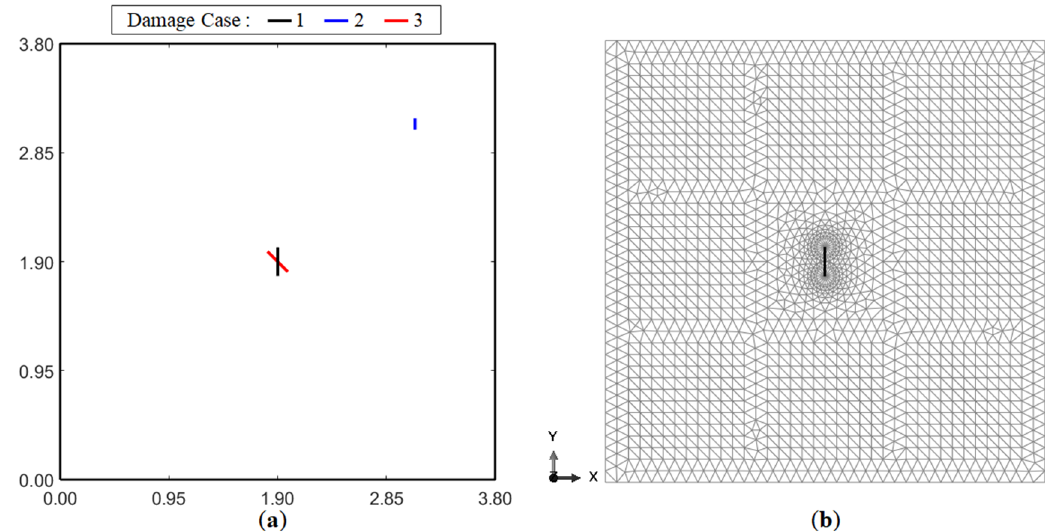
Figure 2. The damaged plate model showing: ( a ) crack size and position for all three damage cases (each crack represents a separate damage scenario), and ( b ) FE mesh used for Damage Case-1.